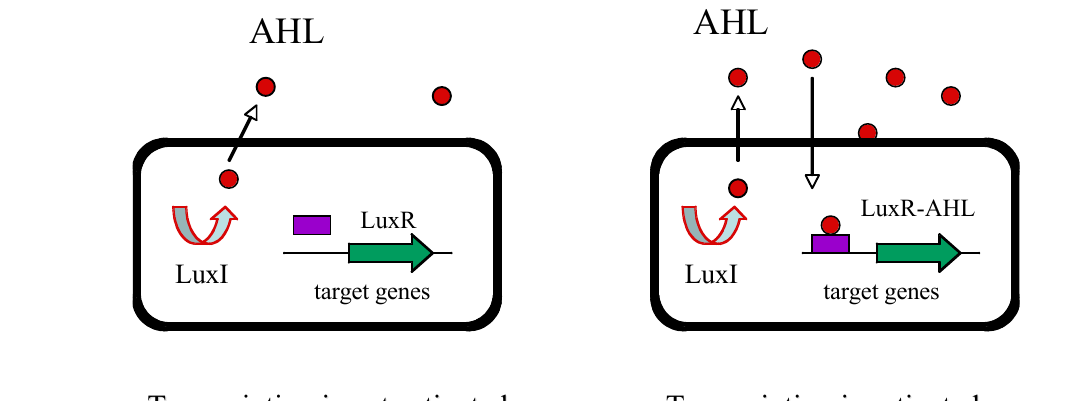
TTranscription is not activated is not activated at at low cell densitylow cell density